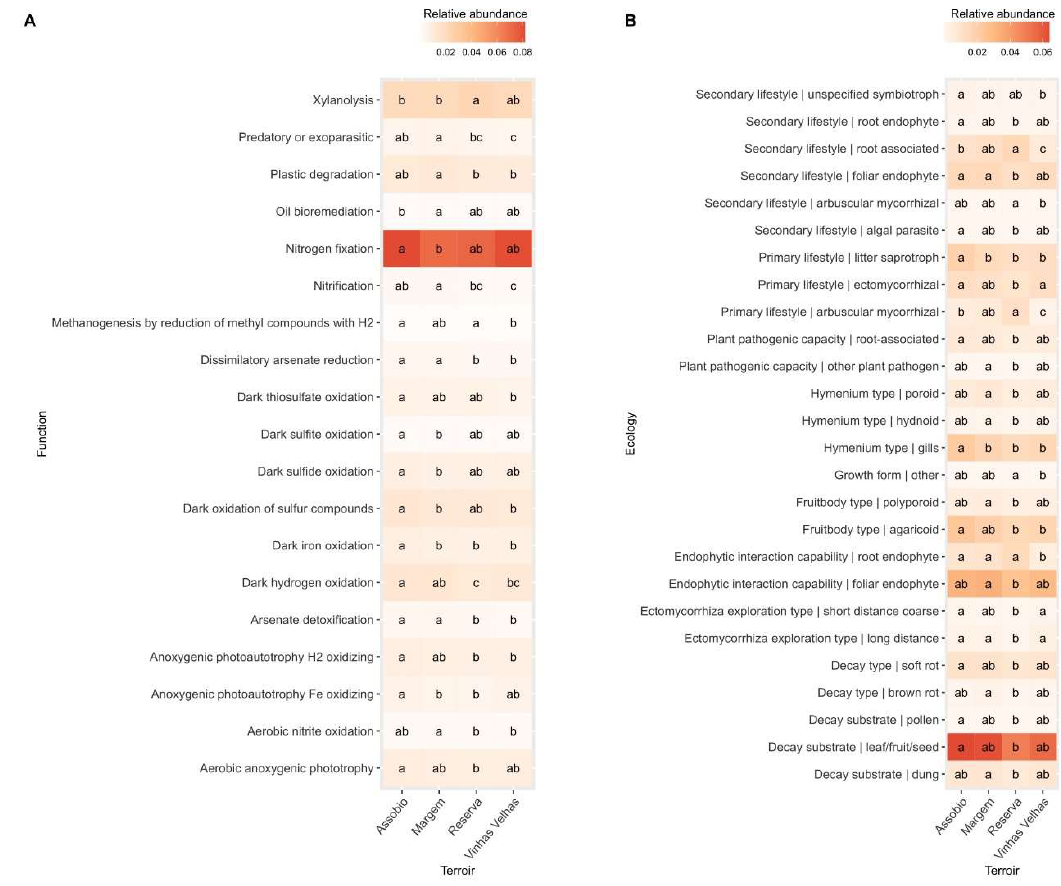
Figure 4. Terroir associated Bacterial functions predicted by FAPROTAX database ( A ) and Fungi ecological guilds predicted by FungalTraits database ( B ) that present statistical significance ( p < 0.05, Kruskal-Wallis, Post hoc test Fisher’s least significant difference with Bonferroni correction adjustment methods; only functions or ecological guilds with significant differences between samples were plotted).